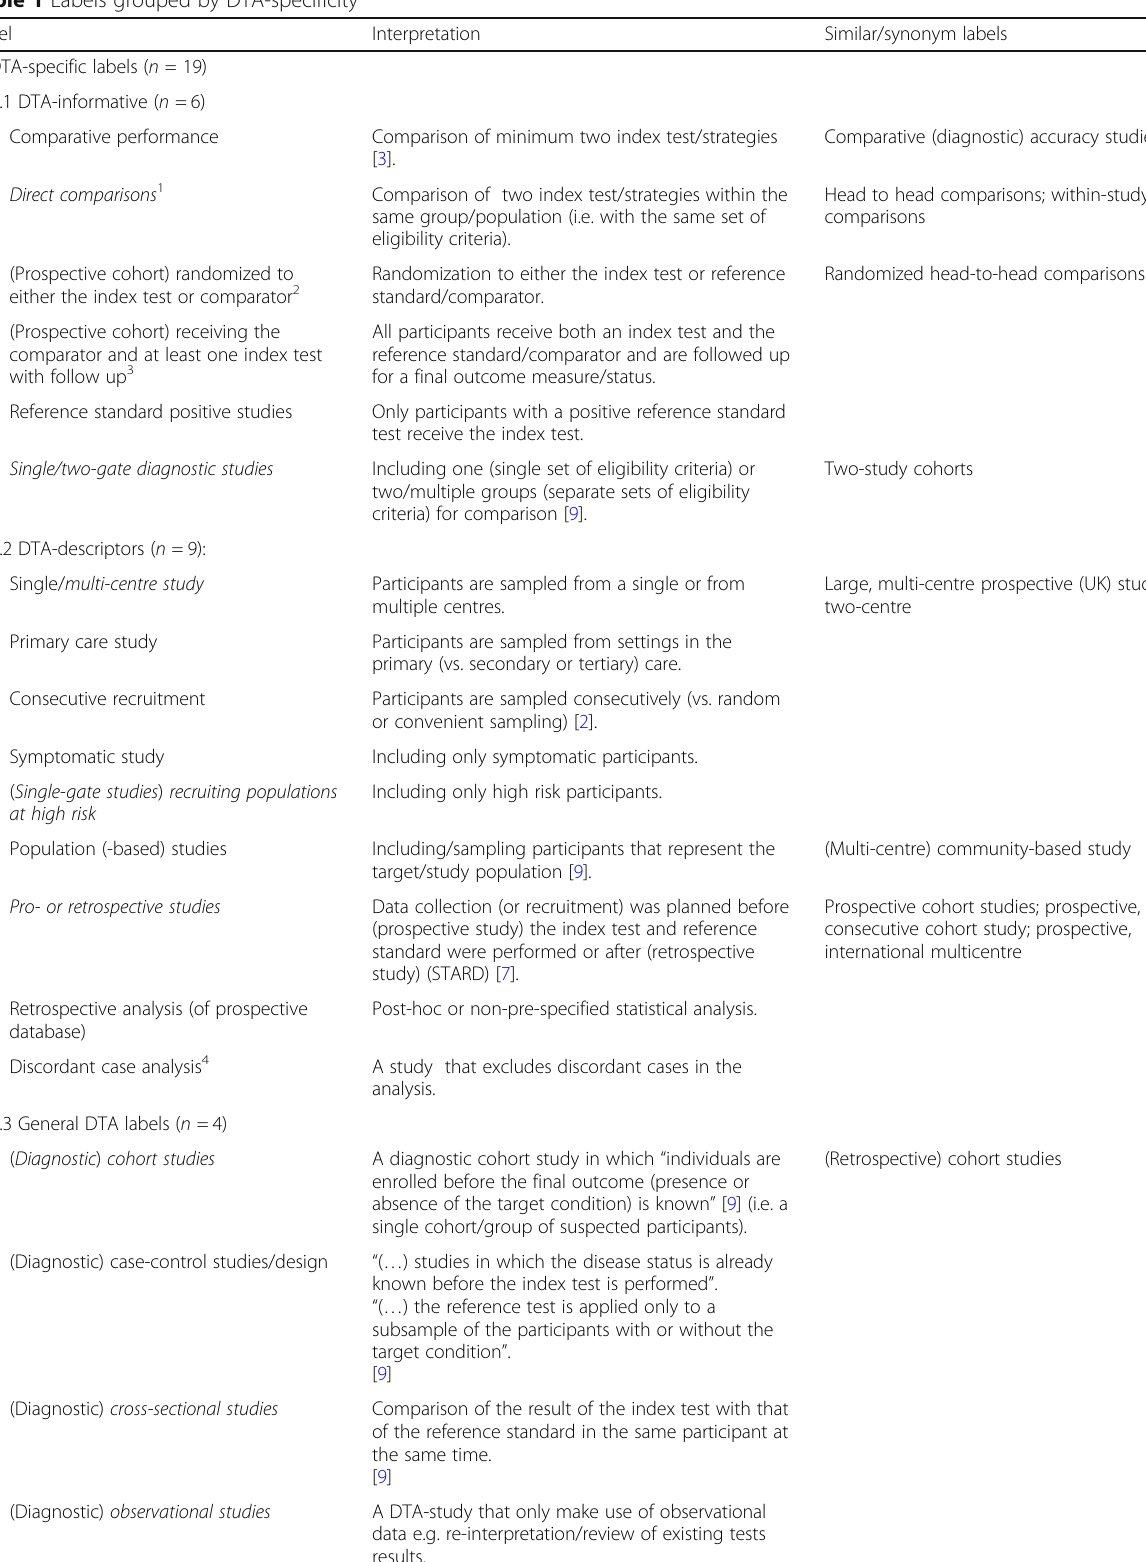
Table 1 Labels grouped by